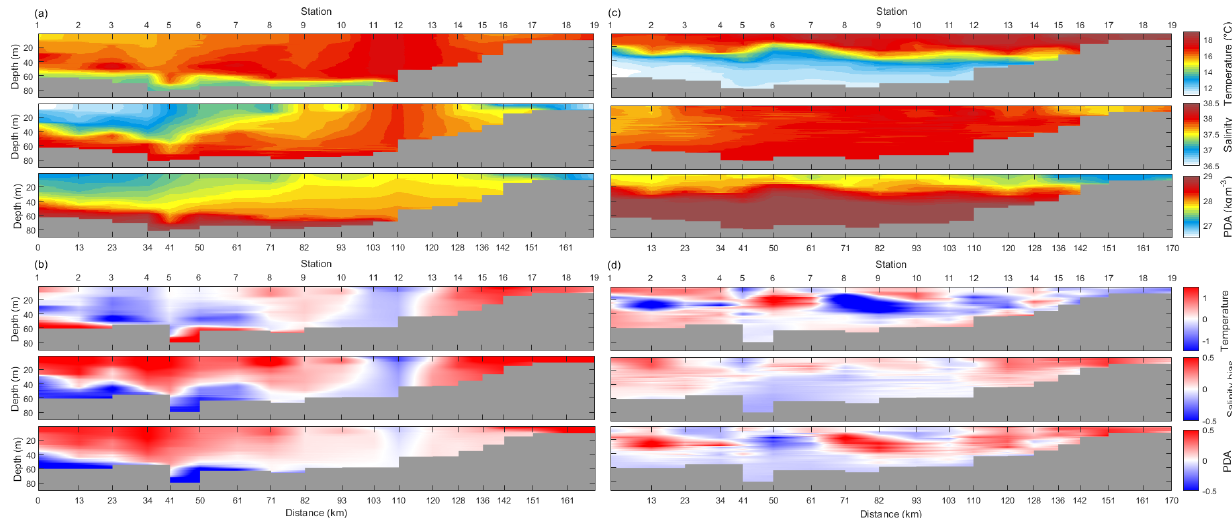
Figure 3. Temperature, salinity and PDA values measured at the Kvarneri´c Channel transect during (a) the leg 1 cruise between 3 and 6 December 2014 and (c) the leg 2 cruise between 26 and 29 May 2015, together with model-to-observation difference (bias) in temperature and salinity estimated for the (b) leg 1 and (d) leg 2